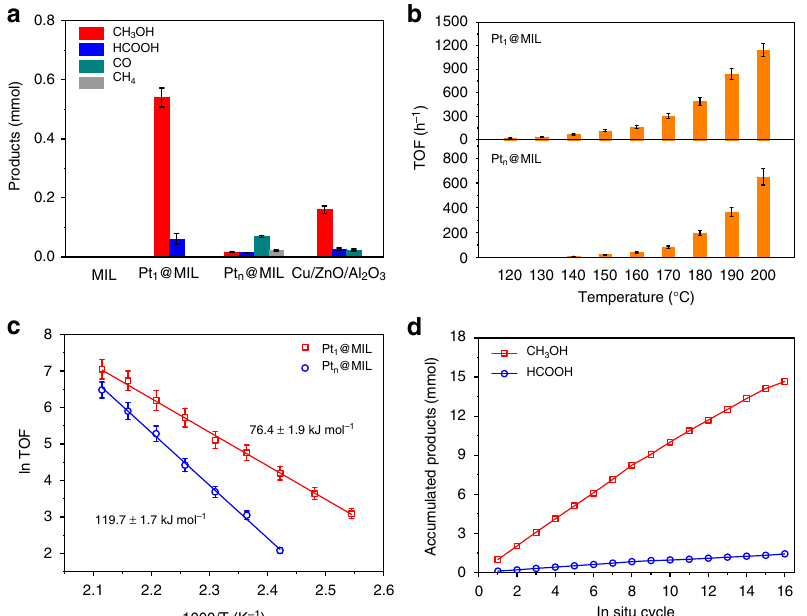
Fig. 2 Catalytic performance of Pt@MIL in CO 2 hydrogenation. a Comparison of products obtained by using MIL-101, Pt 1 @MIL, Pt n @MIL, and commercial Cu/ZnO/Al 2 O 3 in DMF under CO 2 /H 2 mixed gas (CO 2 :H 2 = 1:3, 32 bar) at 150 °C after 1 h. b Comparison of TOF numbers of Pt 1 @MIL and Pt n @MIL in DMF under CO 2 /H 2 mixed gas (CO 2 :H 2 = 1:3, 32 bar) at different temperatures. c The Arrhenius plots of Pt 1 @MIL and Pt n @MIL. d Products obtained by conducting in-situ cycles over Pt 1 @MIL. For each cycle, the catalytic reaction proceeded under 32 bar of CO 2 /H 2 mixed gas (CO 2 /H 2 = 1:3) at 150 °C for 6 h. For each catalytic test, the amounts of Pt 1 @MIL and Pt n @MIL were controlled at 500 and 240 mg, respectively, to keep the same amount (1.0 mg) of exposed Pt atoms. Error bars represent standard deviation from three independent measurements